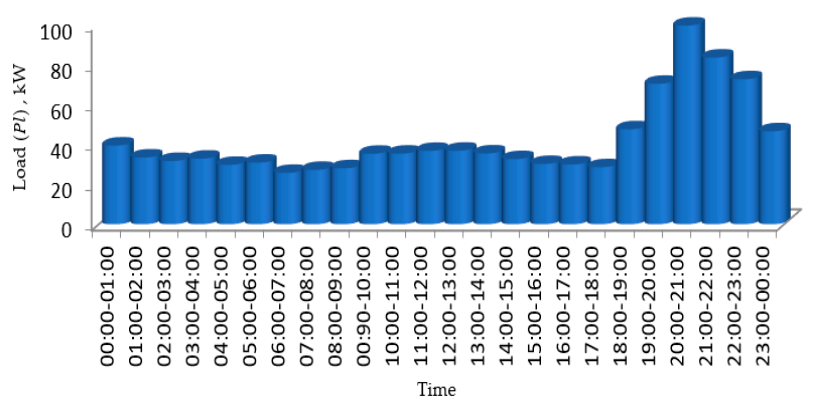
Figure 6. Daily load profile. Table 8. HRES component